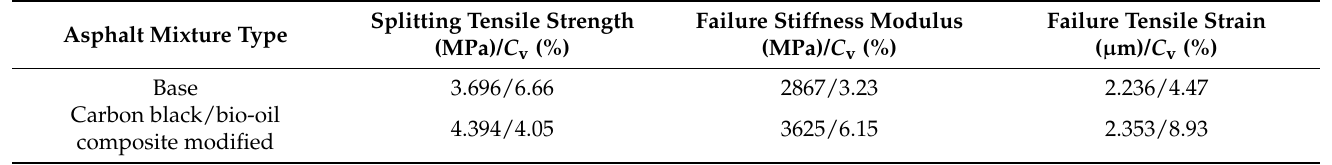
Table 10. Low-temperature splitting test results of different asphalt